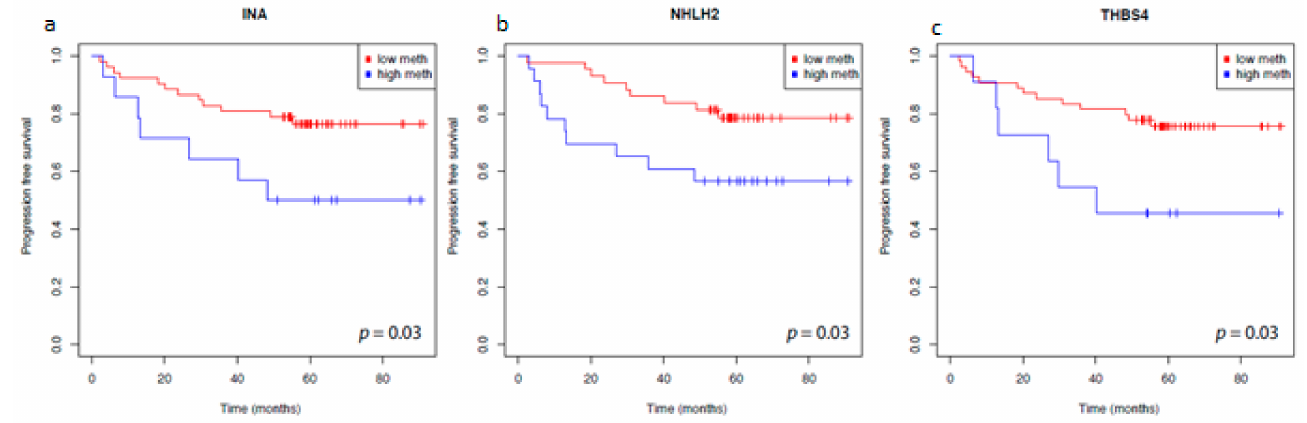
Figure 3. Kaplan–Meier survival analysis of INA ( a ) , NHLH2 ( b ) and THBS4 ( c ) and progression free survival. Blue curve, patients with methylation levels above the gene-specific optimum cut-off. Red curve, patients with methylation levels below the gene-specific optimum cut-off. Optimized cut-off values applied for dichotomization were 24% ( INA ), 11% ( NHLH2 ), and 25% ( THBS4